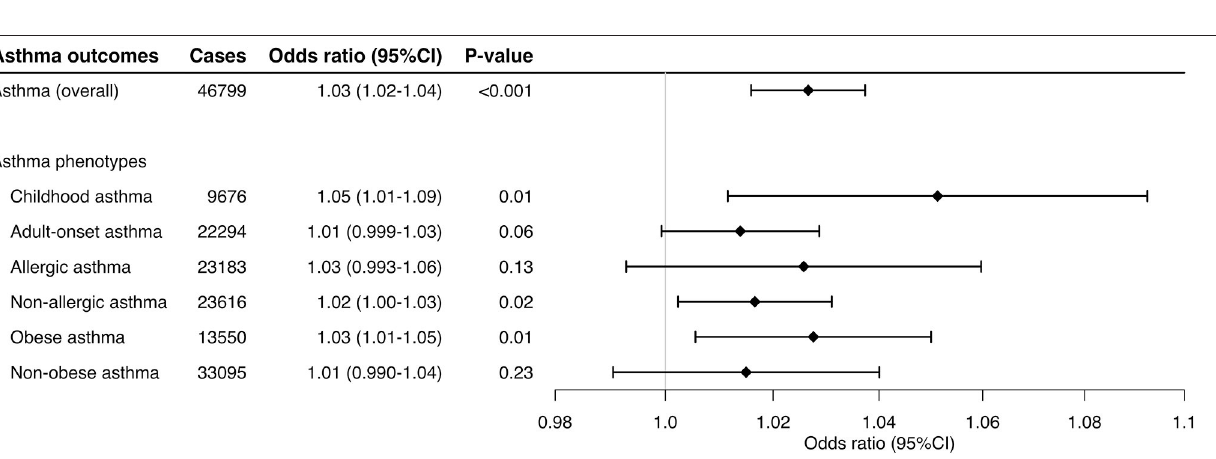
FIGURE 2 | Mendelian randomization estimates for the effect of soluble interleukin-6 receptors on asthma and its phenotypes. By using the inverse variance weighted method, the combined causal effect of sIL-6R on the asthma (overall) outcome and six asthma phenotypes was estimated. The odds ratios were estimated per one standard deviation increment in the inverse-rank normalized sIL-6R level. CI, confidence interval.